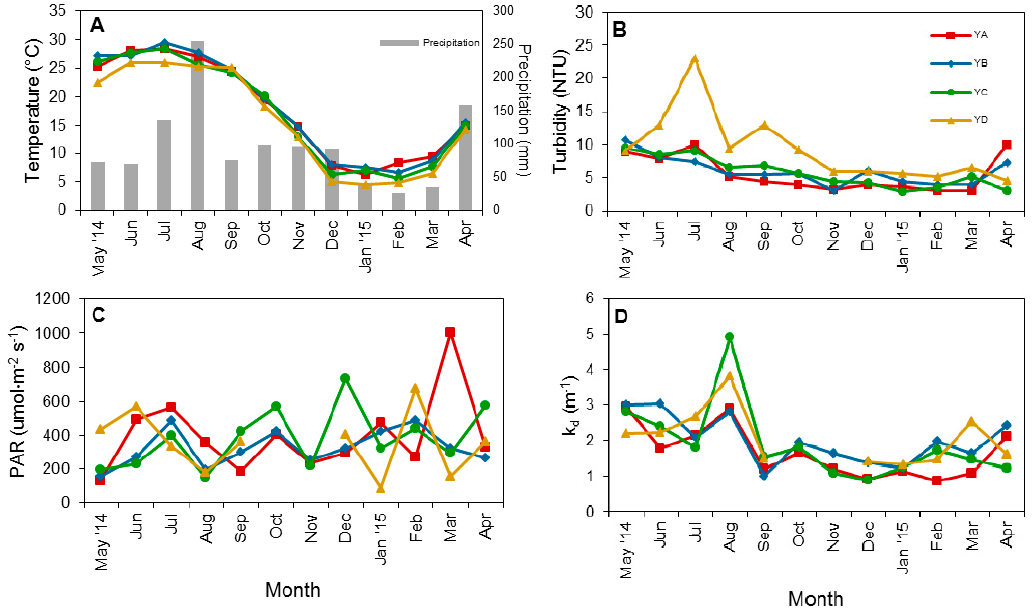
Figure 2. Monthly and spatial variations of physical variables. ( A ) Temperature and precipitation, ( B ) Turbidity, ( C ) photosynthetically active radiation (PAR), and ( D ) light attenuation coefficient at stations YA, YB, YC, and YD in the upper Youngsan River estuary.